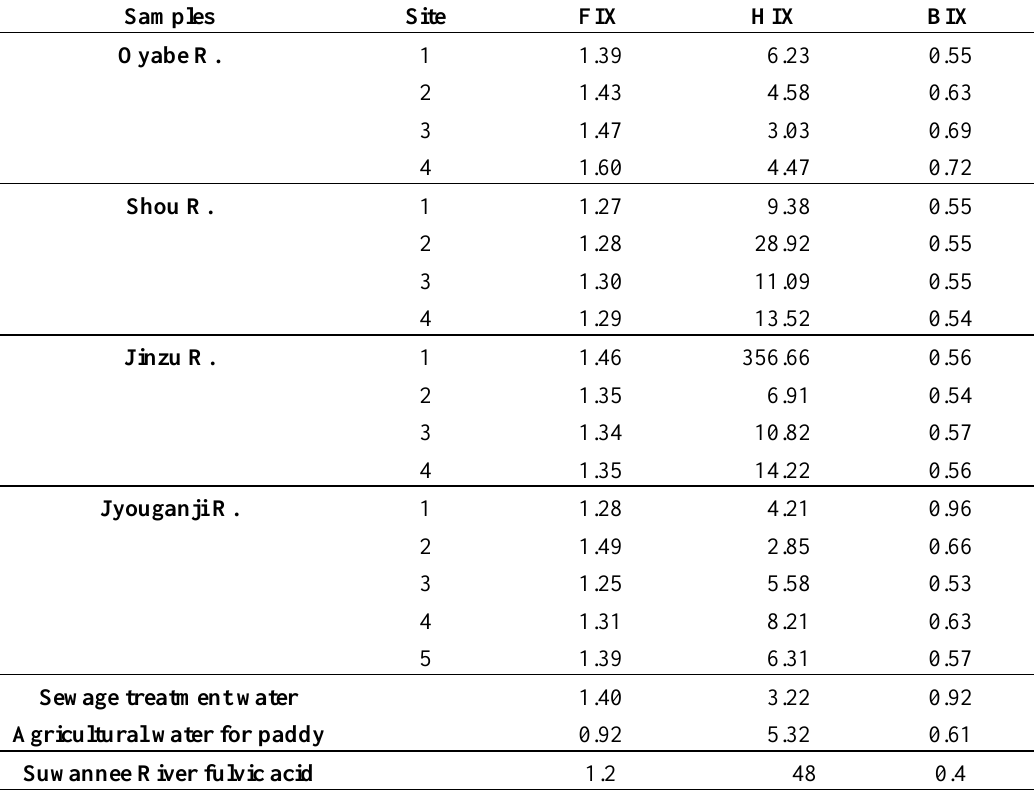
Table 4. The values of FIX, HIX, and BIX for Oyabe River, Shou River, Jinzu River, Jyouganji River, sewage treatment water, and agricultural water for